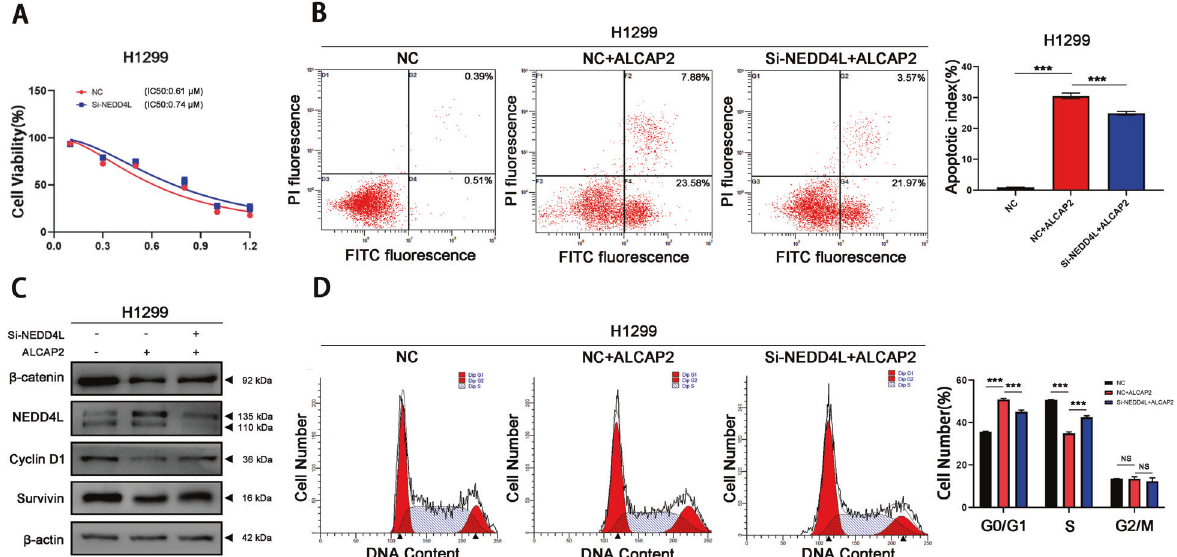
Fig. 6 The effects of ALCAP2 on LUAD cells could be reversed by knockdown of NEDD4L. A The viability of si-NEDD4L H1299 cells after treated with ALCAP2 was determined by MTT assay. B , D Flow cytometry assay to detect the cell cycle and apoptosis of H1299 cells and si- NEDD4L H1299 cells treated with ALCAP2. C The protein expression of β -catenin, NEDD4L, cyclin D1 and survivin. The data were presented as the mean ± SD of three measurements. NS no signi fi cance, *** P <